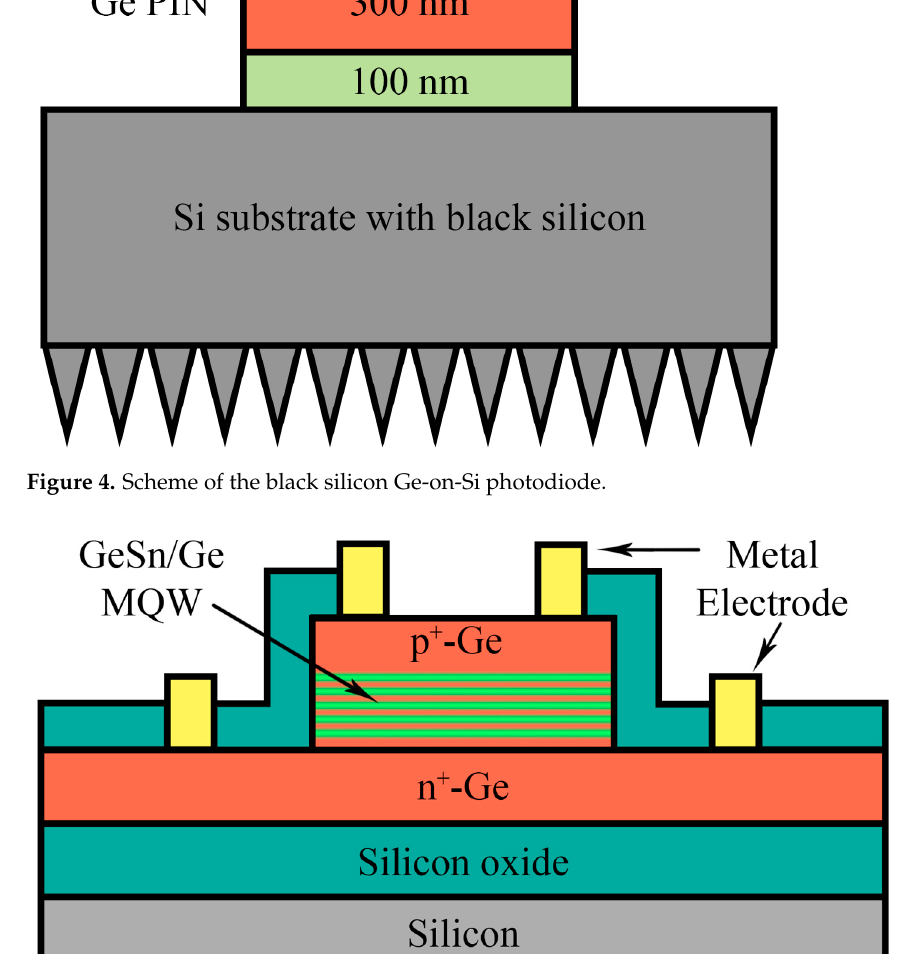
Figure 5. Schematic diagram of the multiple quantum wells GeSn/Ge photodetector with photon-trapping microstructure.